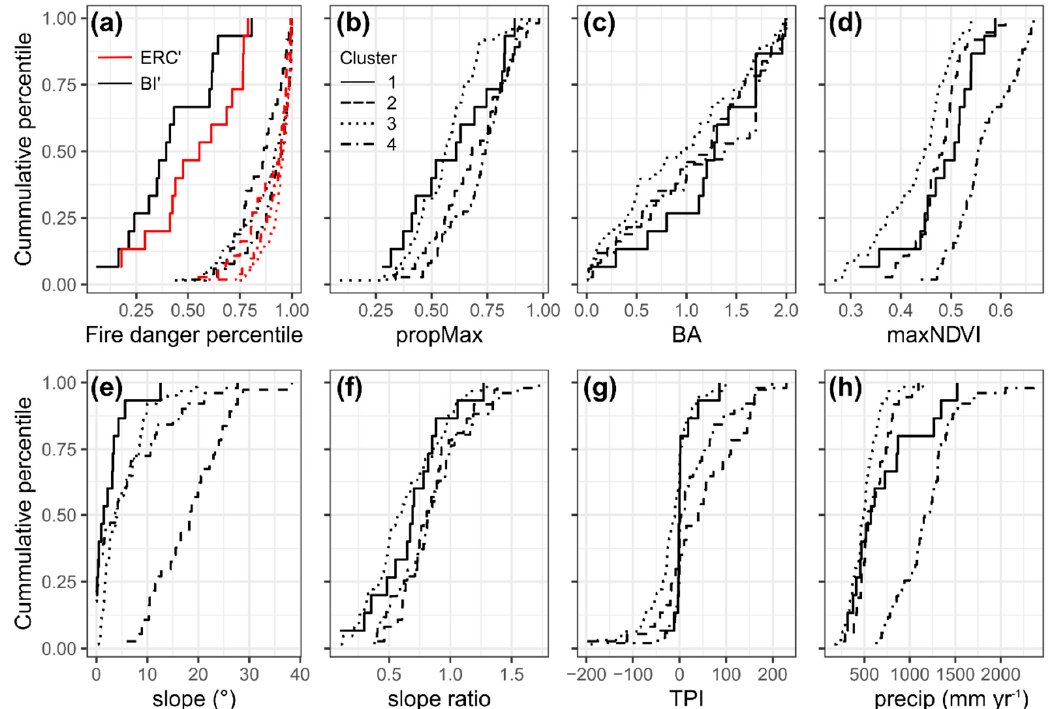
Figure A1. Cumulative percentile distributions by cluster type; cluster 1 (solid line), cluster 2 (dashed line), cluster 3 (dotted line), and cluster 4 (dot-dash line). Data represent distributions for each of the environmental variables ( a – h ) at the times and locations of 166 wildland firefighter entrapments that occurred within CONUS (1981—2017). See Table 2 for variable definitions.